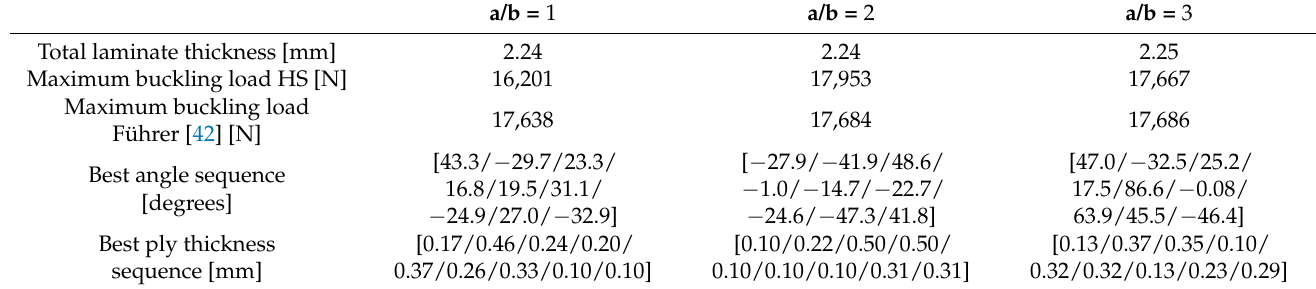
Table 6. The results of the harmony search optimization for the CFRP plates with triangular cut-outs.